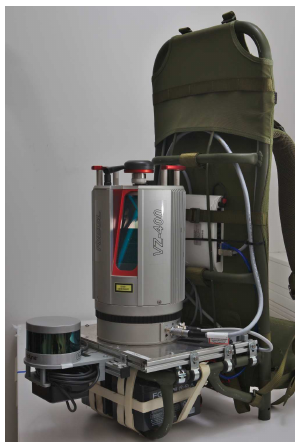
Figure 2. The backpack with Riegl VZ-400 and Velodyne VLP16 Lite laser